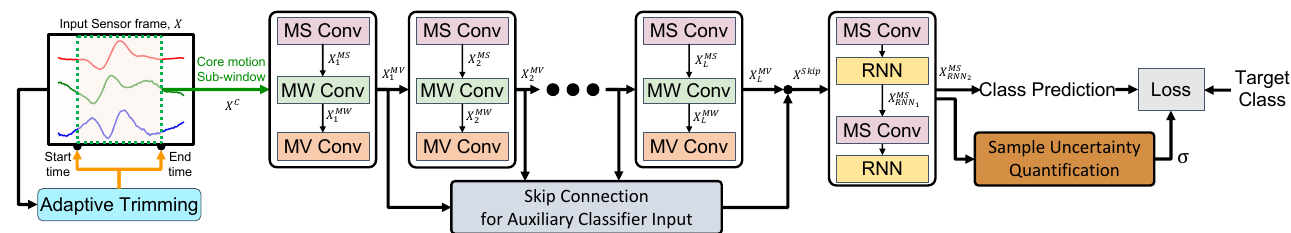
Figure 2. Overview of the novel model architecture for deep learning-based human activity recognition using wearables. An input sensor frame is first processed with Adaptive Trimming (AdapTrimm or AT) to determine the sub-window region that contains the core motion of the target activity. The feature representation is then extracted for this core motion sub- window (green segment). Non-linear multi-scale convolution (MS Conv) captures temporal dynamics at multiple temporal scales. Multi-kernel window convolution (MW Conv) captures varying lengths of motion signals from multi-scale features. Multi-view convolution (MV Conv) uses diverse shapes of convolutional kernels to capture time-channel correlations. The feature representation from intermediate convolutional layers is used as input to the final classifier in the form of auxiliary inputs with skip-connections to enhance gradient flow in the bottom layers of the recognition network. The convolutional feature representations are aggregated by a non-linear multi-scale recurrent neural network (MS RNN), which is used to predict the activity class of the input sensor frame. Along with the class label, the confidence for the prediction is generated by the model, which is for loss calculation to regularize the contribution of noisy inputs for model updates during